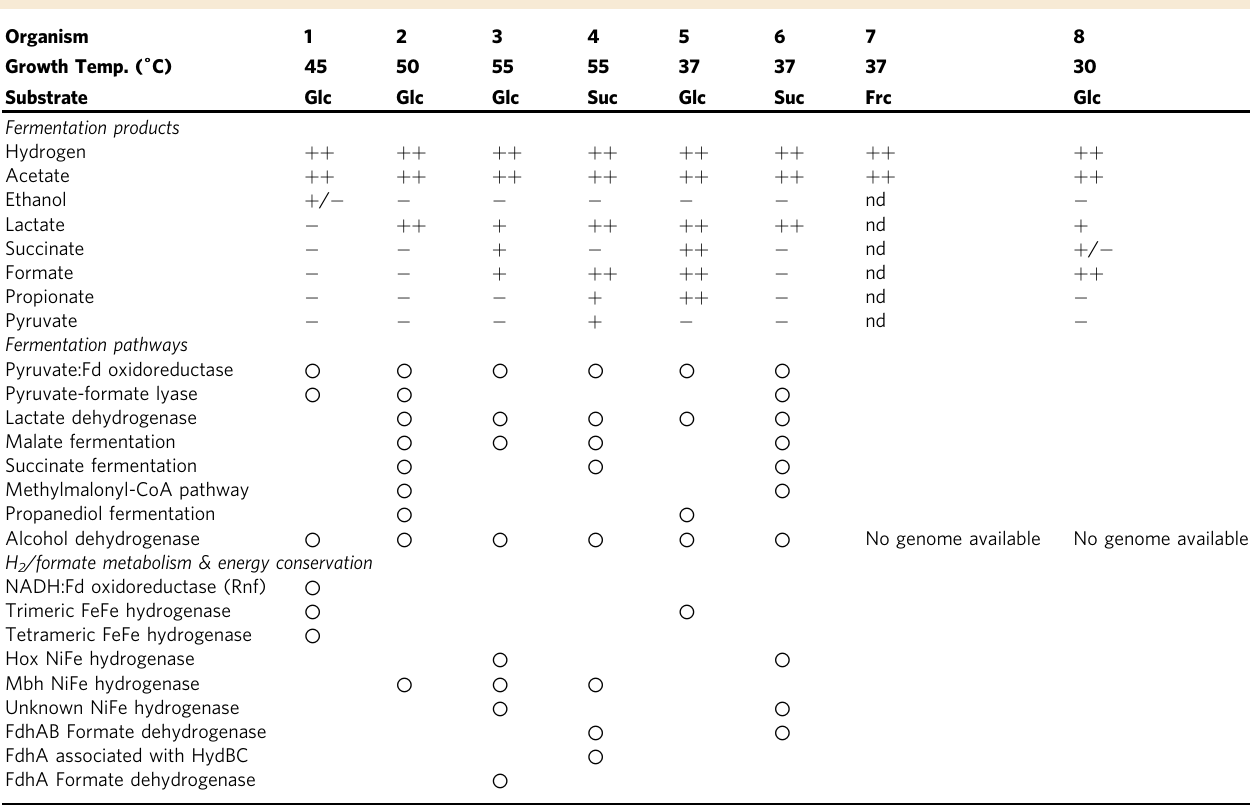
Table 1 Fermentation products and genome-predicted metabolic properties of semi-syntrophic anaerobes that bene fi t from interaction with methanogenic